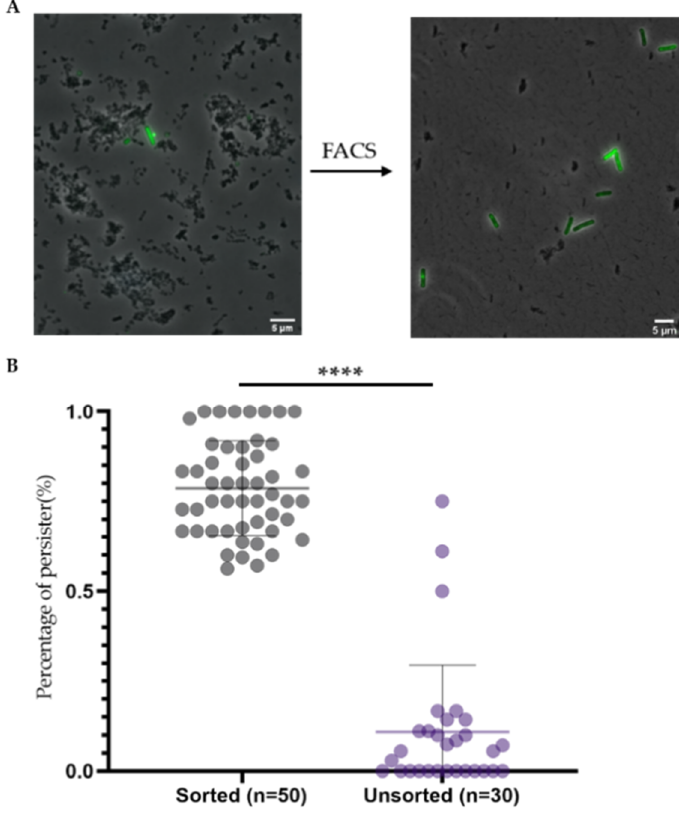
Figure 4. Double staining and subsequent cell sorting significantly enriched persisters. To isolate persisters, antimicrobially treated cultures were firstly double stained with 5(6)-CFDA and PI, then 5(6)-CFDA + -PI − cells were sorted with fluorescence activated cell sorting (FACS). ( A ) An example of a merged microscopic image with persisters before and after FACS showed that FACS enriched persisters and decreased the amount of debris at the same time. The images are merged images of phase contrast channel, 5(6)-CFDA channel and PI channel. ( B ) The percentage of persisters as observed in single microscopic images significantly increased after FACS. ****: p < 0.0001. On average, in one analyzed image, there was only 1 persister cell before FACS while 10 persisters were observed after sorting.